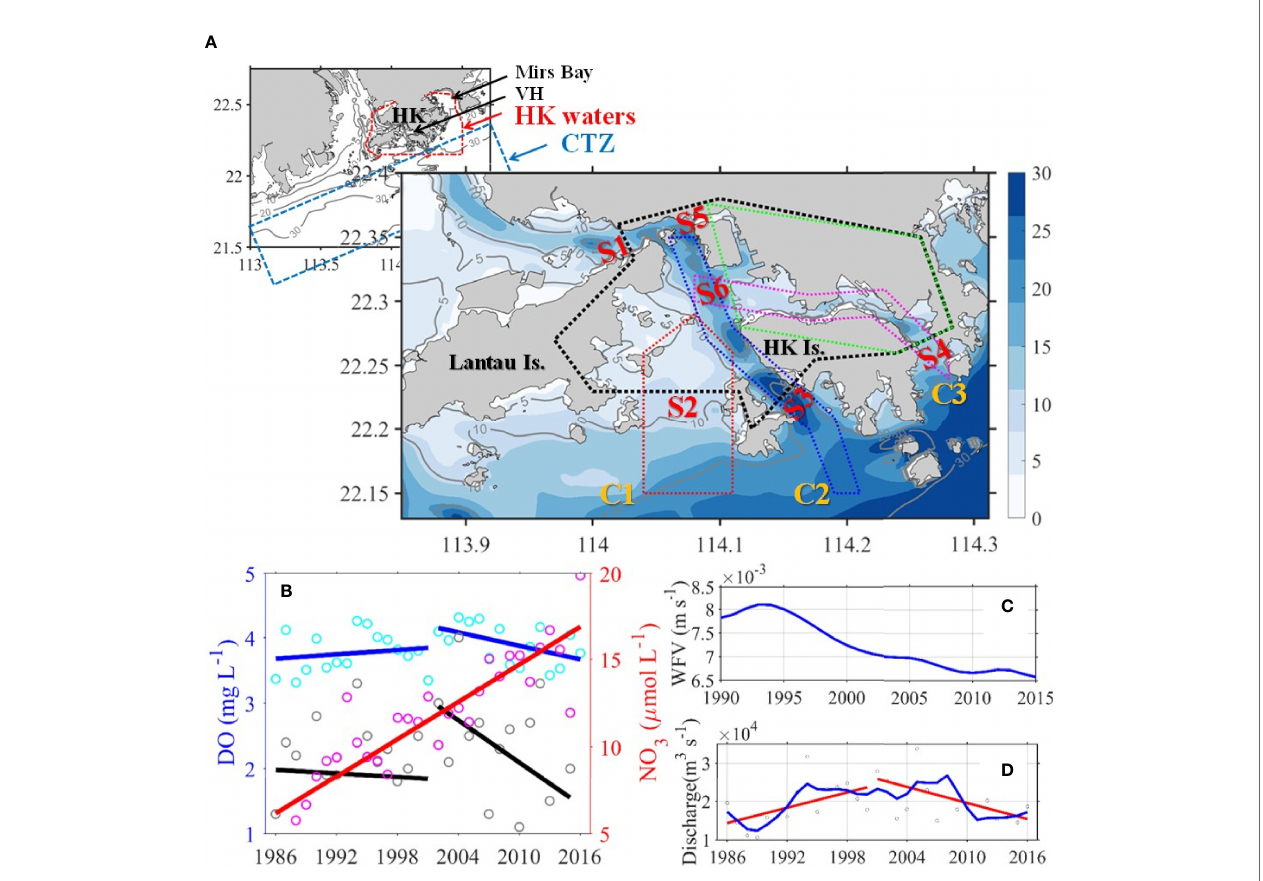
FIGURE 1 | (A) Map with topography and isobaths (in meters) of the study area. In the upper left small map, the waters enclosed by red dashed line is the Hong Kong waters (HKW), the regions enclosed by blue dashed line represent the Coastal Transition Zone (CTZ). In the big map, the area enclosed with black and green dotted lines represents the Greater and Central Victoria Harbour (VH and CVH), respectively. The area enclosed with red, blue, and pink dotted lines indicates Channel 1 – 3 (also marked with C1-3 in yellow), respectively. S1-6 in red represents sections 1 – 6, respectively. (B) Time-series (1986 – 2016) of the surface NO 3 (pink open circles represent the mean value of all stations, the red solid line is the trend lines by linear regression) and the bottom DO (cyan open circles represent the mean value of all stations, gray open circles represent the lowest value, blue and black solid lines are trend lines of mean and lowest values, respectively) in the CVH during summer (Jul. and Aug. average). (C) Summer mean wind friction velocity (blue solid line) of WGL (HKO). (D) Summer mean freshwater discharge of Pearl River (grey open circles represent mean value, the blue solid line represents smoothed time-series variation, red solid lines are trend lines), data were obtained from Gaoyao hydrological